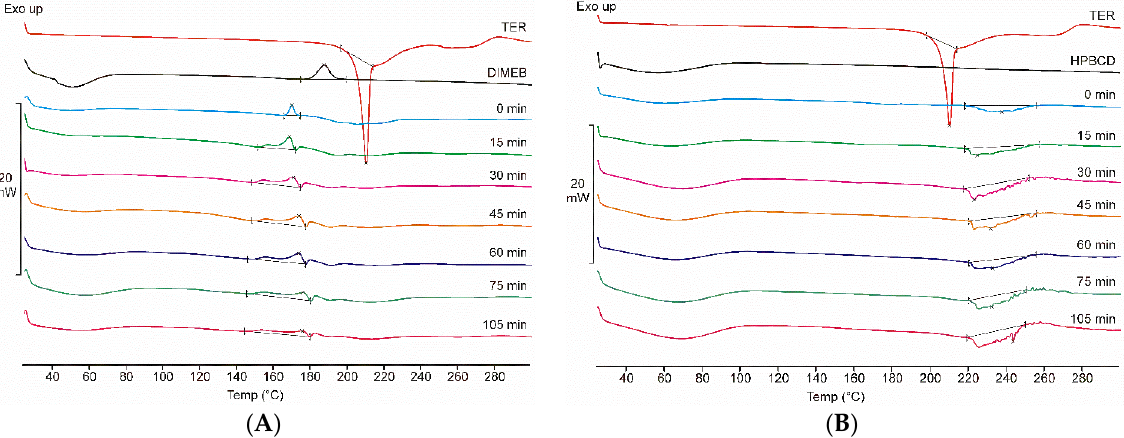
Figure 2. DSC thermograms of raw materials, physical mixture (0 min), and products (15 – 105 min) containing DIMEB ( A ) and HPBCD ( B ). In the case of DIMEB products, an exothermic peak appears before the melting point of the active substance. In the case of HPBCD products, a complex endothermic peak appears at higher